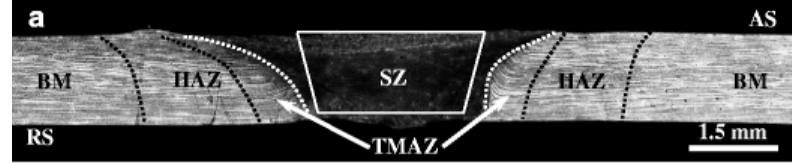
Figure 2. A typical macroimage of di ff erent microstructural zones in a FSWed material (reproduced from [94], with permission from Springer, 2017).